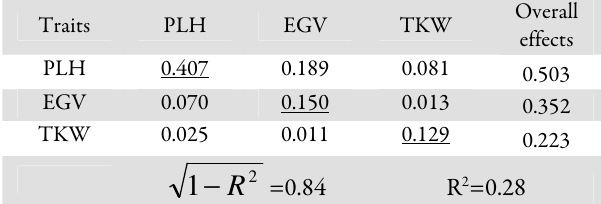
SL: spike length; CTA: canopy temperature at anthesis; EGV: early growth vigor